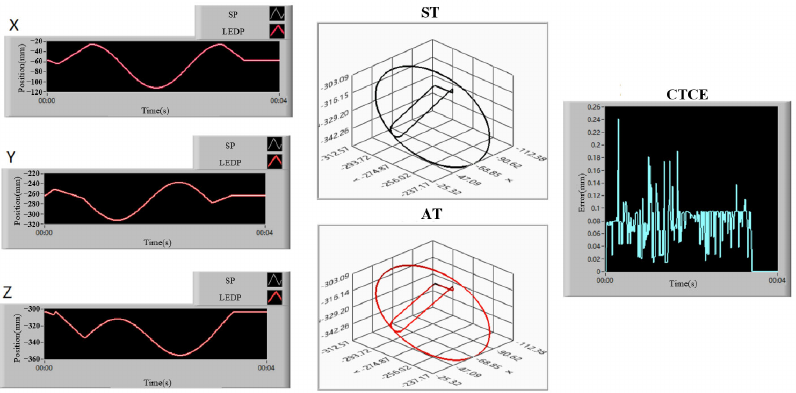
Figure 23. The results of real ‐ time data collection and CTCE prediction.